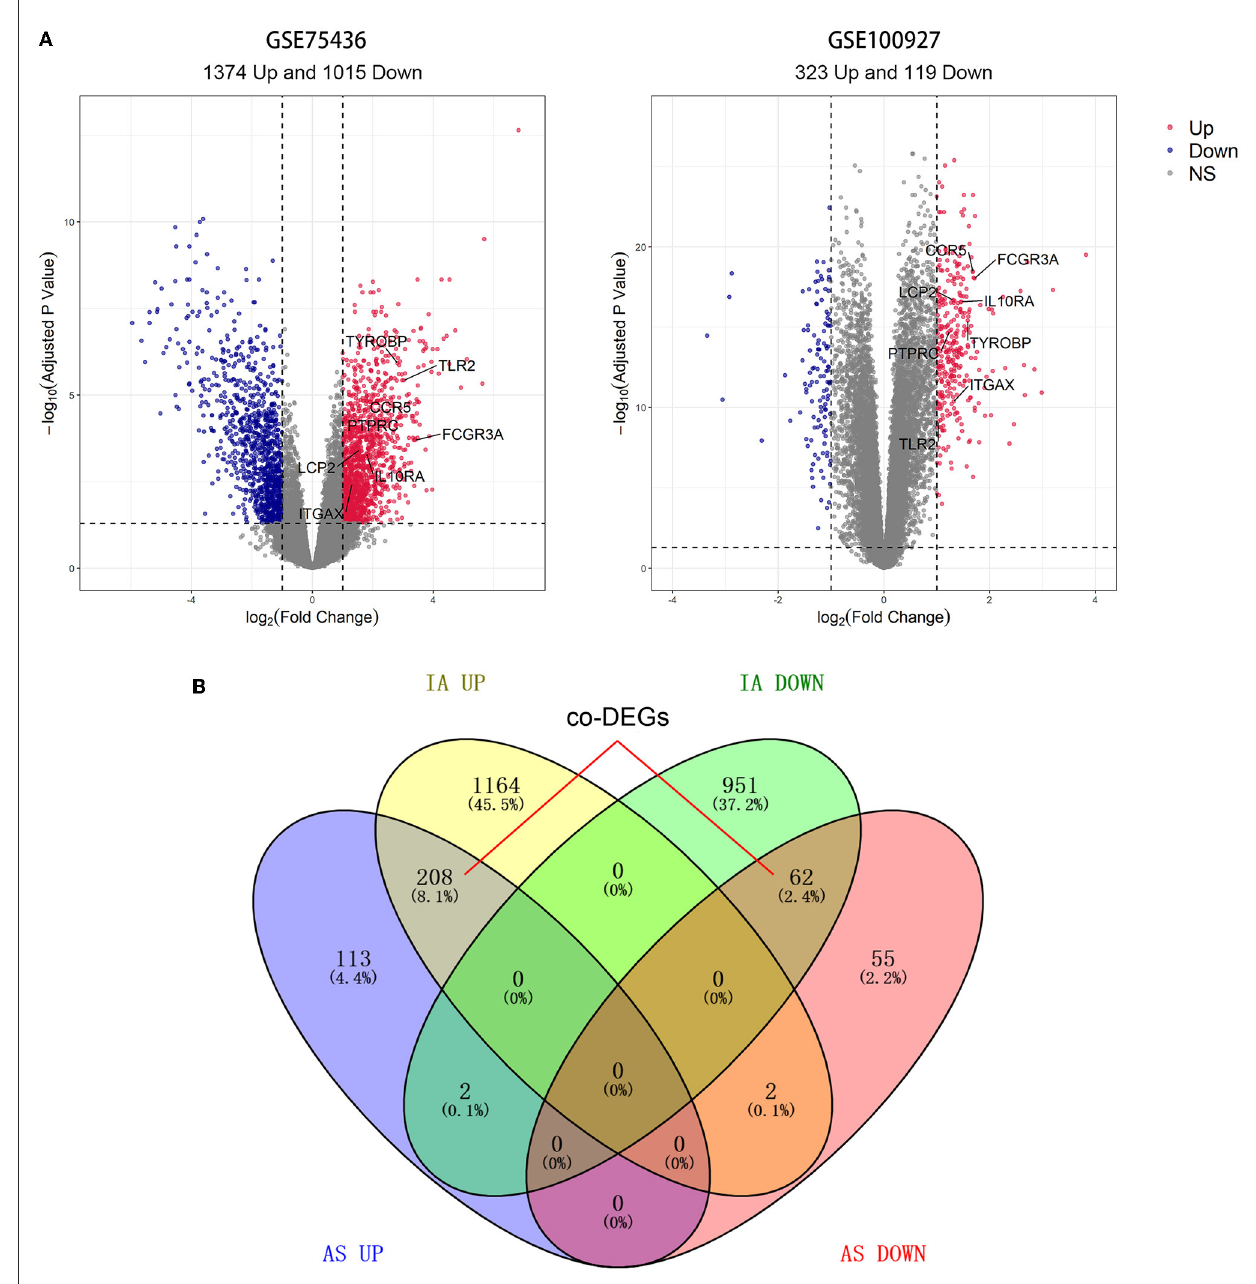
FIGURE2 Results of differential expression analysis and intersection Venn diagram. (A) The volcano map of GSE75436 and GSE100927. Bright red color indicates upregulated genes; blue color indicates downregulated ones. (B) From the DEGs of the two datasets, 270 co-DEGs were